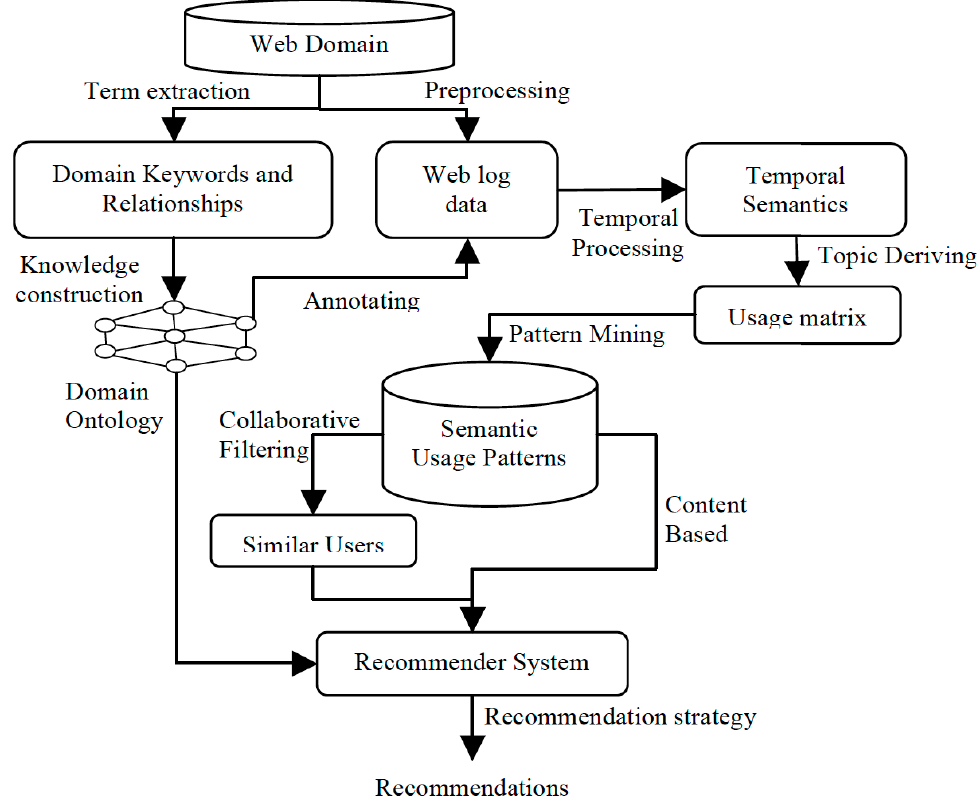
Figure 1. Architecture of proposed hybrid recommender